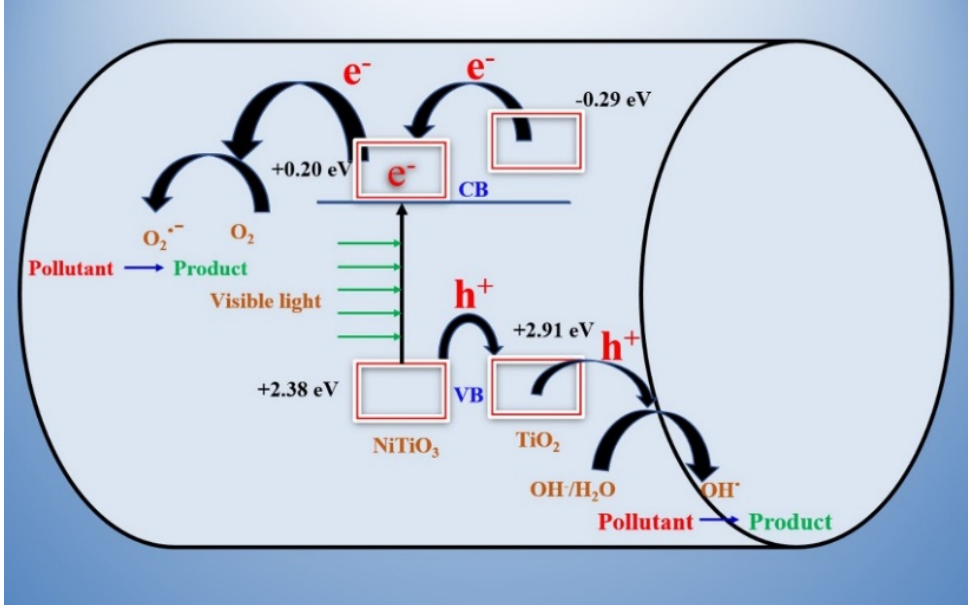
Figure 11. Schematic diagram for the creation and influence of electrons and holes in the photocatalytic degradation of MB.